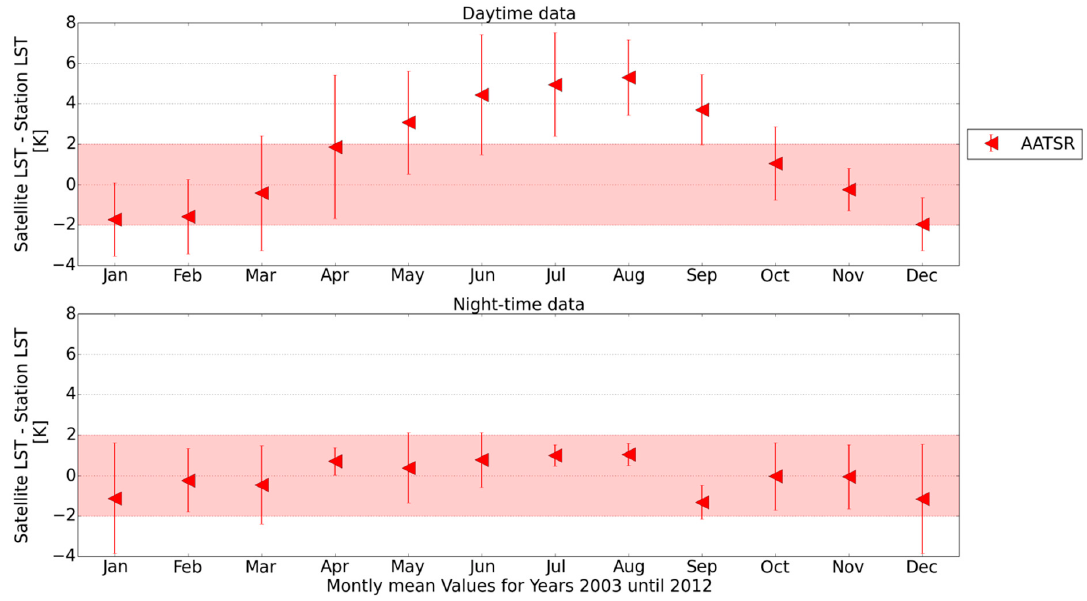
Figure 5. Monthly median accuracies (AATSR LST–Station LST) over FPK station for years 2003–2012. The ranges shaded in red indicate the accuracy range of ± 2.0 K, the symbols are the medians, and the error bars are the robust STDs.